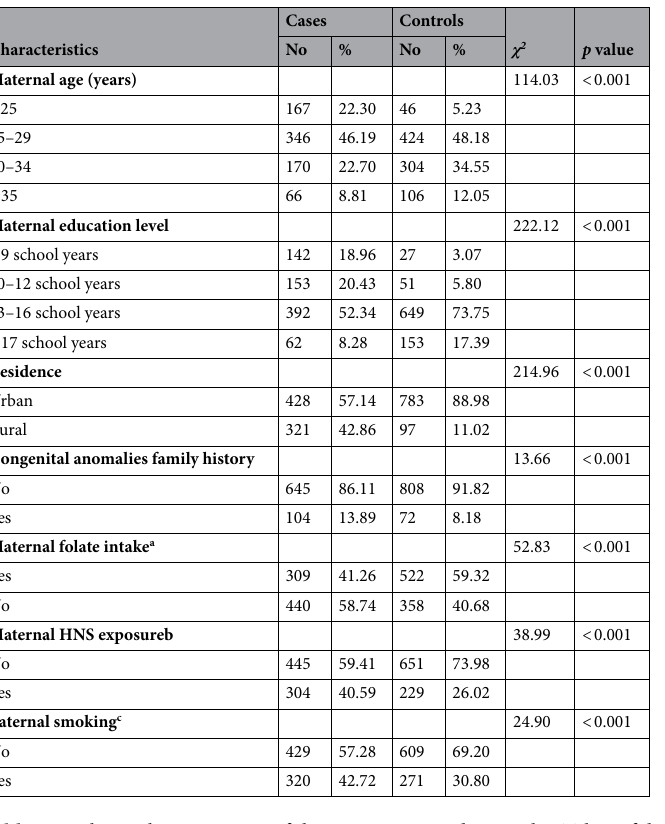
Table 1. Subject characteristics of the CHD cases and controls. a Taking folic acid over 90 days or more during the 3 months before conception to the first trimester. bMaternal HNS (maternal hazardous and noxious substances) exposure during the 3 months before conception to the first trimester. c Paternal smoking during 0–3 months before